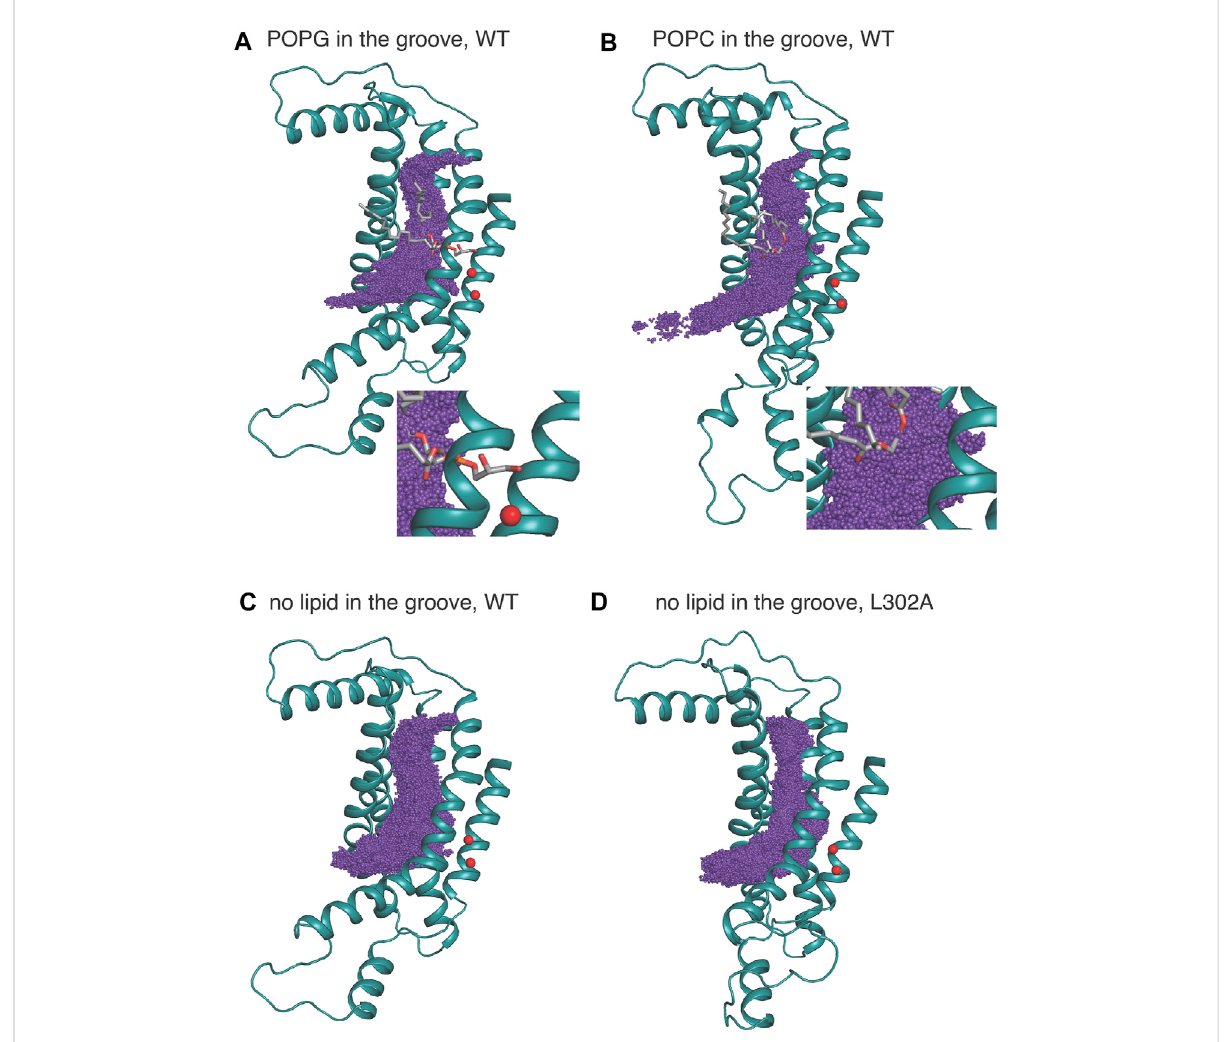
FIGURE 6 K + positions from all equilibrated frames of the umbrella sampling simulation indicated by purple spheres in a structural representation of the grooveinwhichonlyTM3 – TM7areshownforclarity,renderedintealcartoon.Thein-groovelipidisrenderedinlicorice, andCa 2+ ionsareshownas red spheres. (A) is for System 1; (B) isfor System 3, (C) isfor System 2, and (D) isfor the nhTMEM16 L302A mutant. System 4 issimilar to System 2 and therefore not shown. The insets in (A,B) show an enlarged view of the sampling near either the POPG (A) or POPC (B)